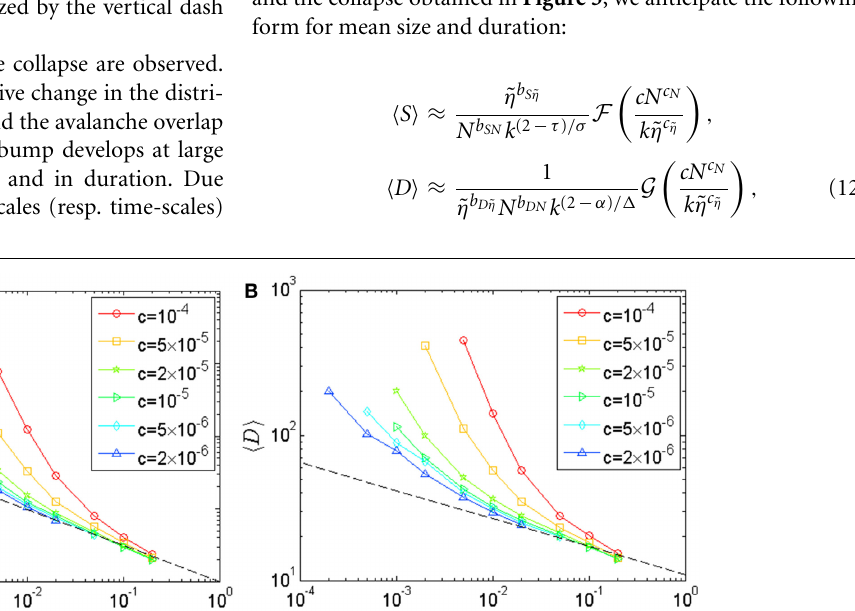
the main panel of Figure 7A , {(cid:4) S (cid:5) → (cid:4) S (cid:5) / ˜ η b S ˜ η , c → c / ˜ η c ˜ η } in the main panel of Figure 7B , {(cid:4) D (cid:5) → (cid:4) D (cid:5) / N − b DN , c → c / N − c N } in the main panel of Figure 7A (cid:6) , {(cid:4) D (cid:5) → (cid:4) D (cid:5) / ˜ η − b D ˜ η , c → c / ˜ η c ˜ η } in the main panel of Figure 7B (cid:6) . By combining this with Equation 11